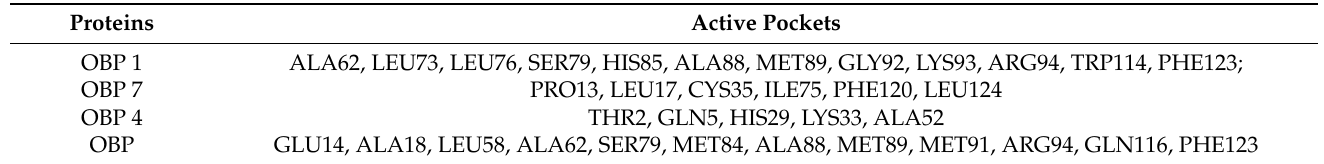
Table 6. Active pockets on the four selected odorant binding proteins of A. gambiae .